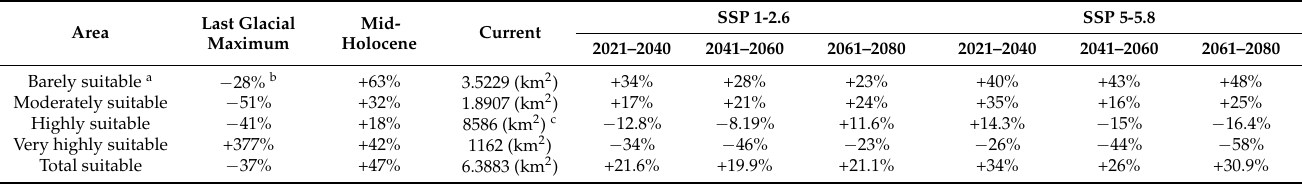
Table 2. The distribution area of F. strictus under climate change.